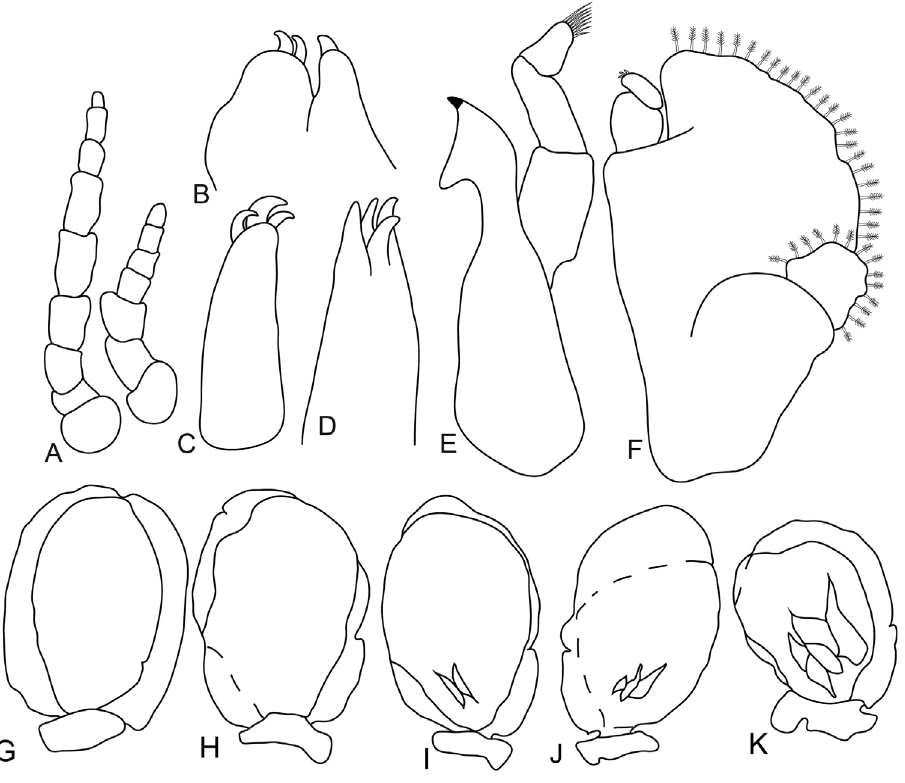
Figure 6. Anilocra brillae sp. n. female paratype (39 mm) (AMNH_IZC 250210) A, G–K Anilocra bril- lae sp. n. female (pleotelson damaged) B–F : A antenna (left) and antennula (right) B maxilla C article 3 of maxilliped D maxillule E mandible F maxilliped G–K pleopods 1–5